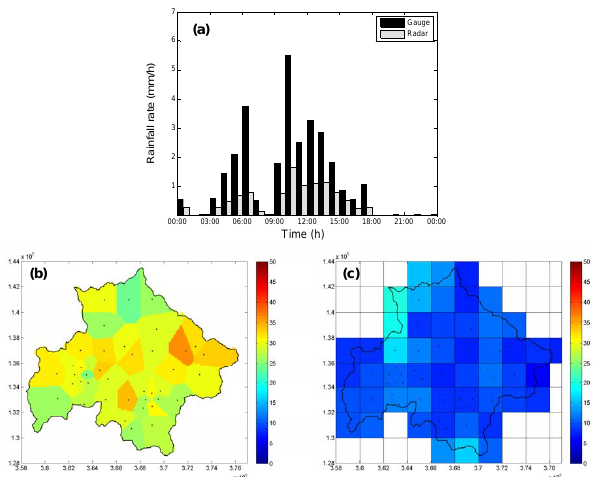
Figure 4 Comparison of the Wardon Hill radar and the rain gauge network: (a) time series bars of the hourly catchment areal rainfall; (b) 24h rainfall accumulation observed by the rain gauge network (mm); (c) 24h rainfall accumulation measured by the weather radar (mm)